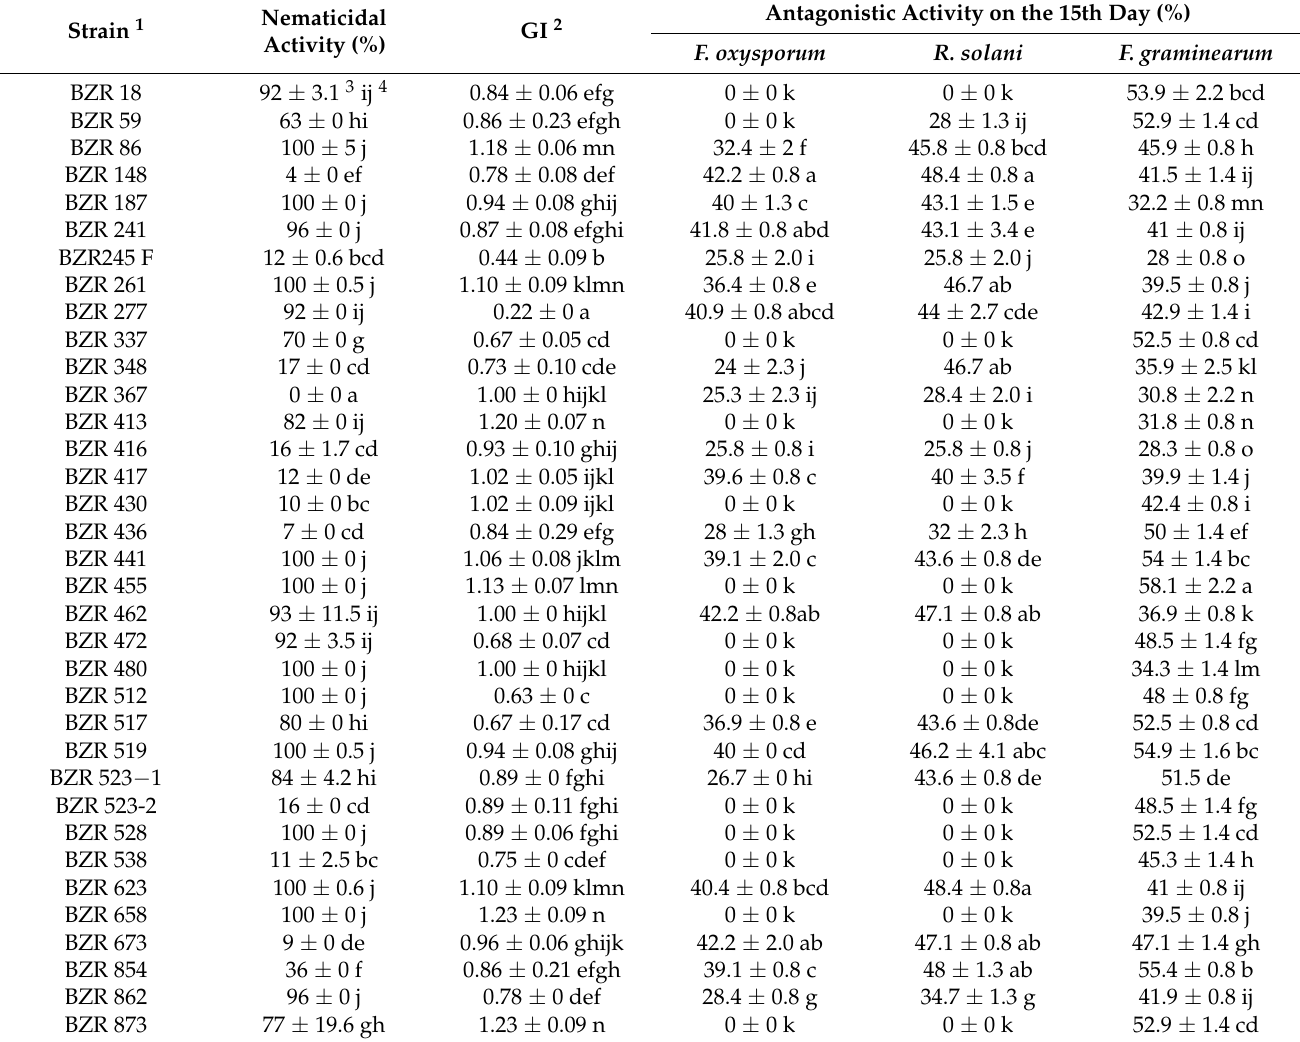
Table 1. Germination index, nematicidal and antagonistic effects of bacterial strains selected from the Bioresource Collection of FSCBPP.